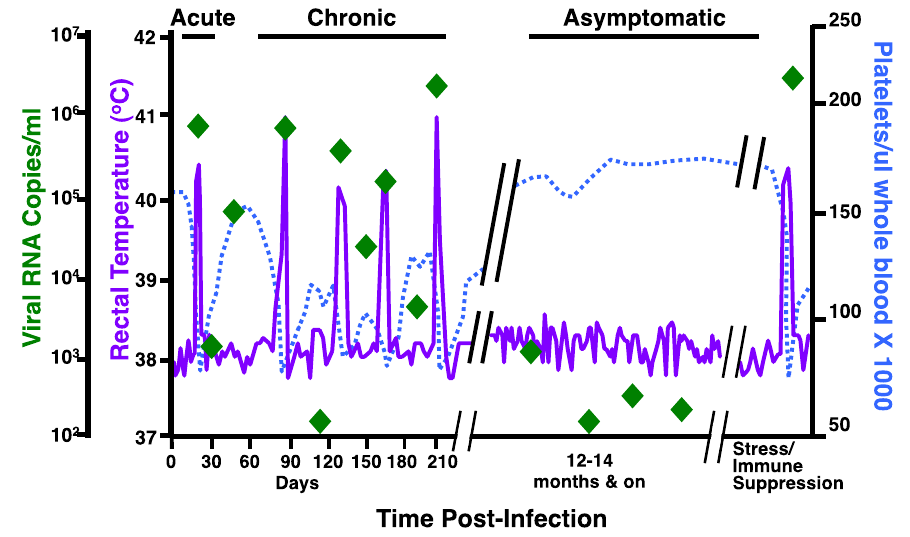
Figure 1. Profile of equine infectious anemia virus (EIAV) clinical disease. A schematic diagram representing a typical clinical profile over elapsed time associated with EIAV infection of equines indicating the characteristic stages of EIA disease. Febrile episodes are defined as rectal temperatures above 39 °C (103 °F), thrombocytopenia is defined as platelet levels below 105000/  L of blood, and a viremia of  10 5 copies RNA/mL